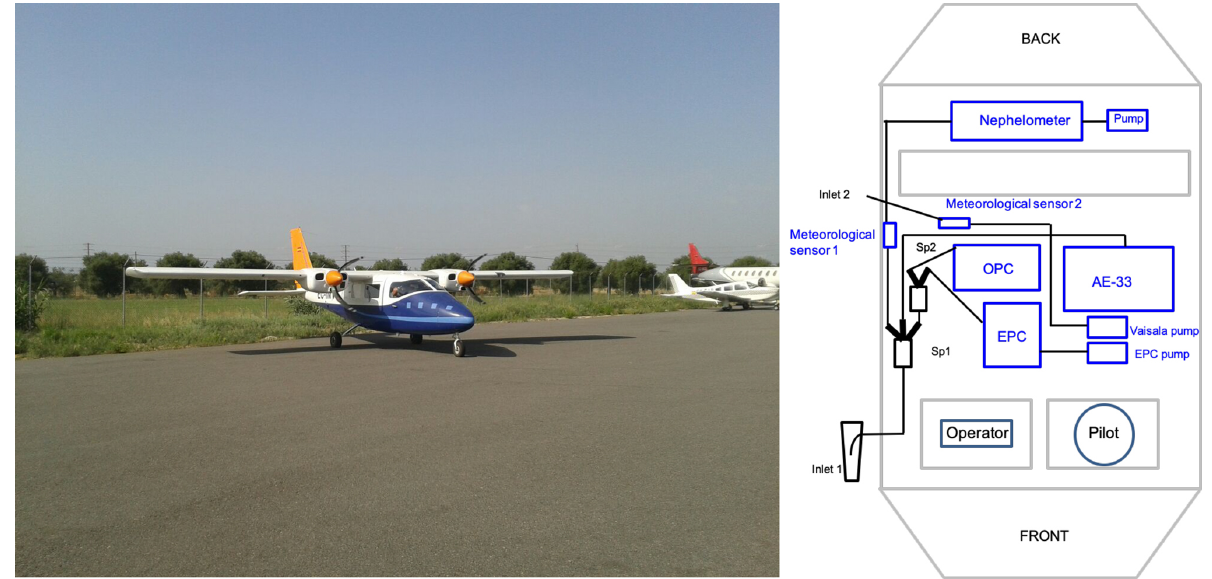
Figure 4. Piper PA 34 Seneca aircraft (left panel) and the schematic of the aerosol inlet and sampling instruments inside the aircraft (right panel). Aerosol sampling lines are shown in black, and sampling instruments are in blue. EPC: environmental particle